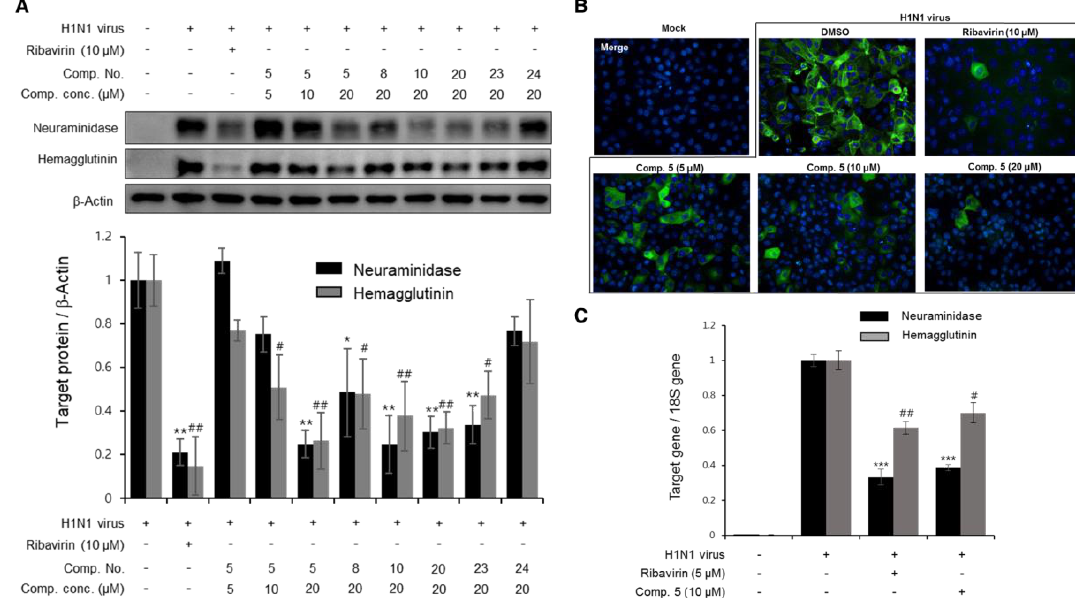
Figure 4. Relative mRNA and protein viral expression levels decreased after treatment with several compounds from P. densiflora . ( A ) Madin – Darby Canine Kidney (MDCK) cells were infected with the H1N1 virus for 2 h and then treated with compounds 5 , 8 , 10 , 20 , 23 , and 24 at various concentrations. After 24 h of incubation, viral NA and HA were evaluated by Western blot analysis. Data are presented as the mean ± SD ( n = 2 − 4), * p < 0.05, ** p < 0.01, and # p < 0.05, ## p < 0.01 compared to the NA and HA virus control groups, respectively. ( B ) Compound 5 reduced NA in the cytoplasm of viral-infected cells as measured by the immunofluorescence method. After infection with the H1N1 virus for 2 h, MDCK cells were incubated with compound 5 or ribavirin as a positive control for 24 h. The cells were then fixed, stained, and visualized using a fluorescence microscope. ( C ) Compound 5 decreased the mRNA levels of NA and HA induced by virus replication in MDCK cells as assessed by real-time PCR. Values are expressed as the mean ± SD ( n = 3), *** p < 0.001, and # p < 0.05, ## p < 0.01 compared to the NA and HA virus control groups, respectively.